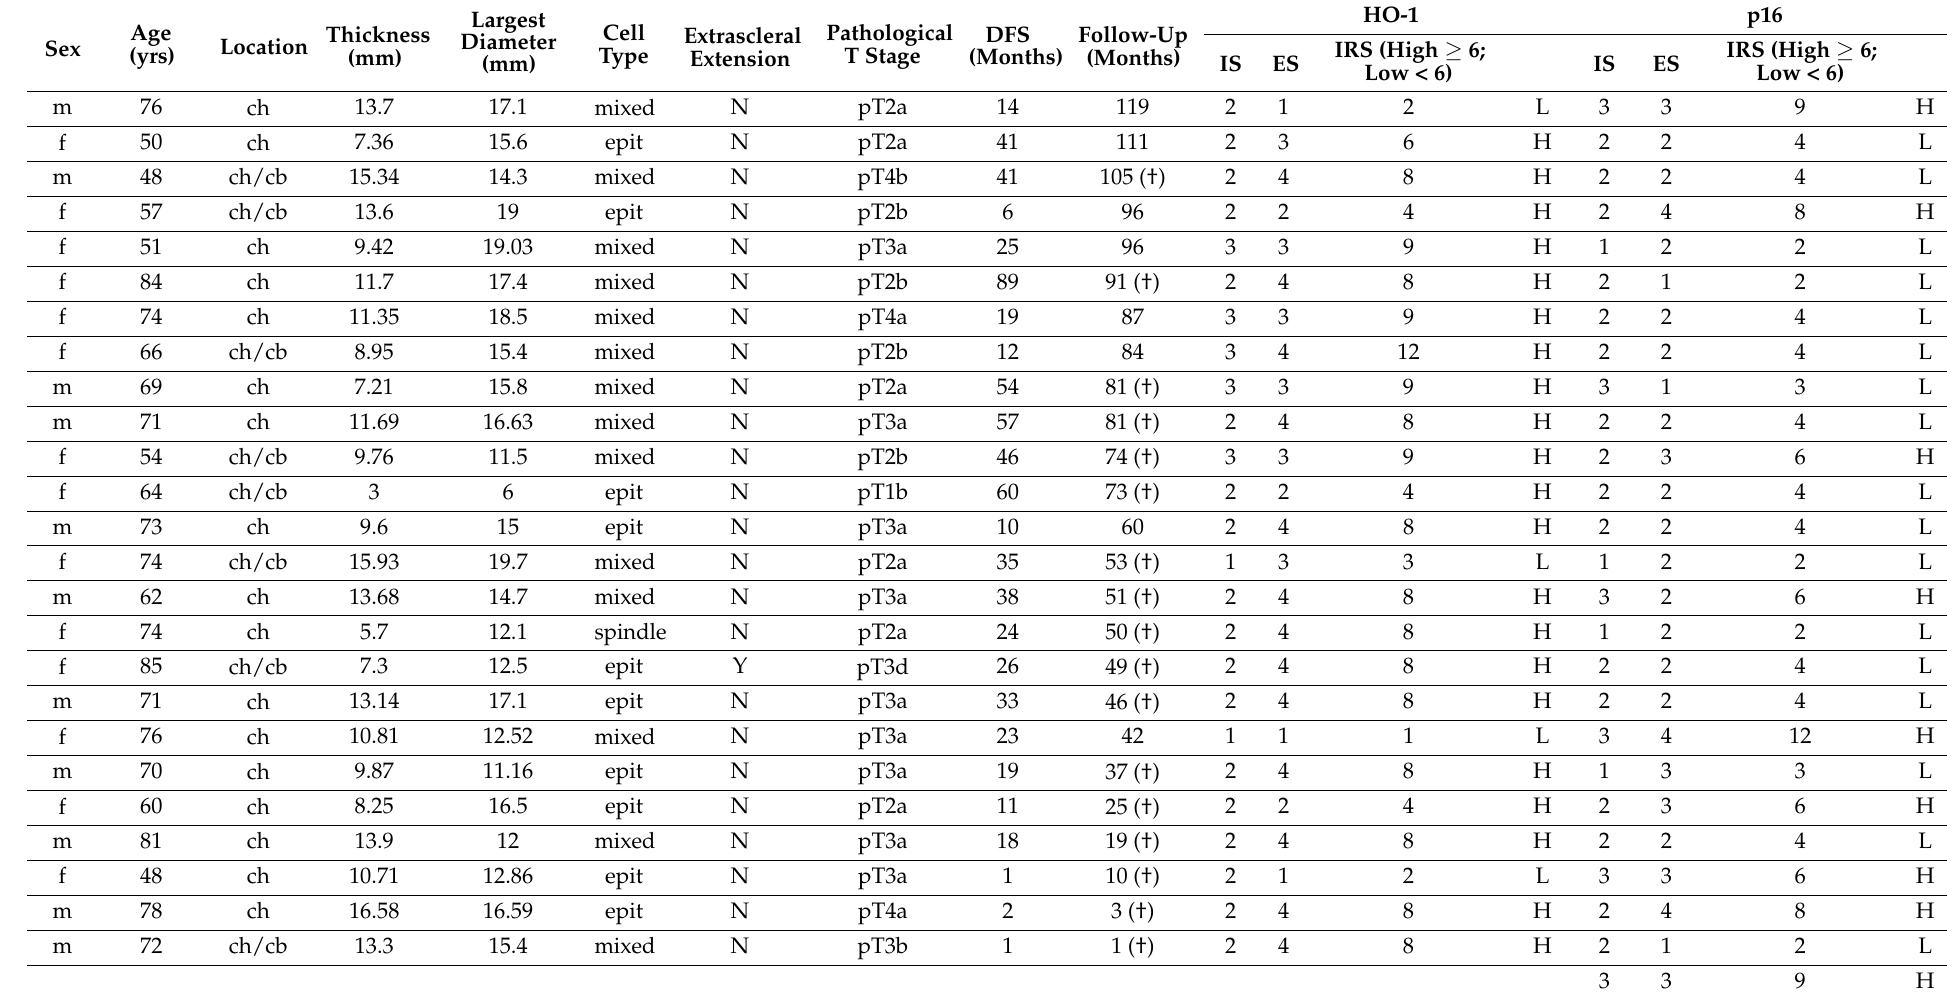
Table 3. Demographics, tumor parameters, disease-free time, follow-up, and HO-1 expression in primary uveal melanoma with metastasis. (n =